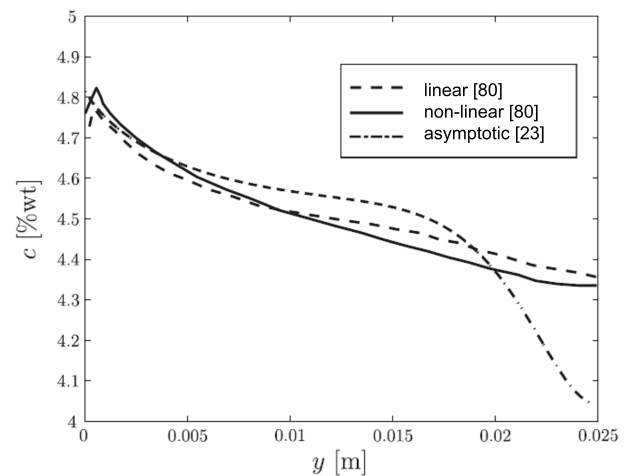
Figure 14. Comparison of the macrosegregation profiles obtained in [80], using the linearized and non-linearized phase diagrams for the Al-Cu system, and using the asymptotic model in